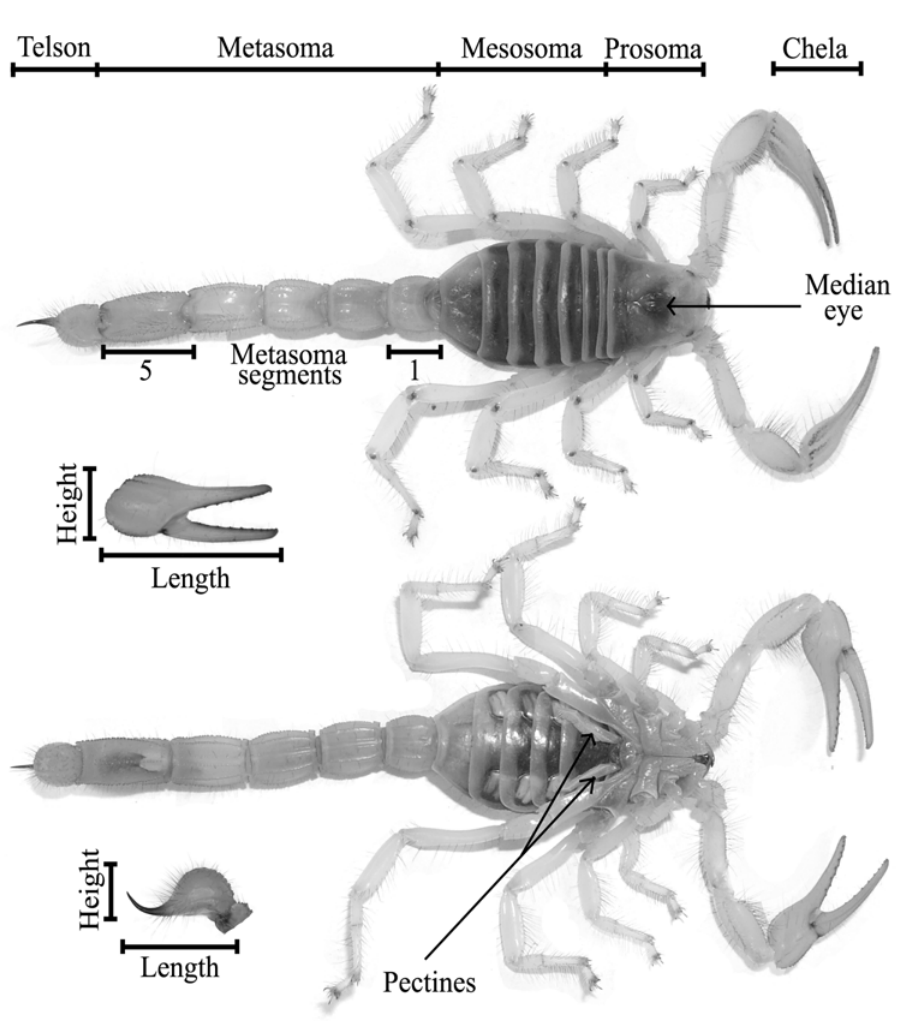
Fig 1. Morphology of representative Desert Hairy scorpion ( Hadrurus arizonensis ). Body components measured in this study are